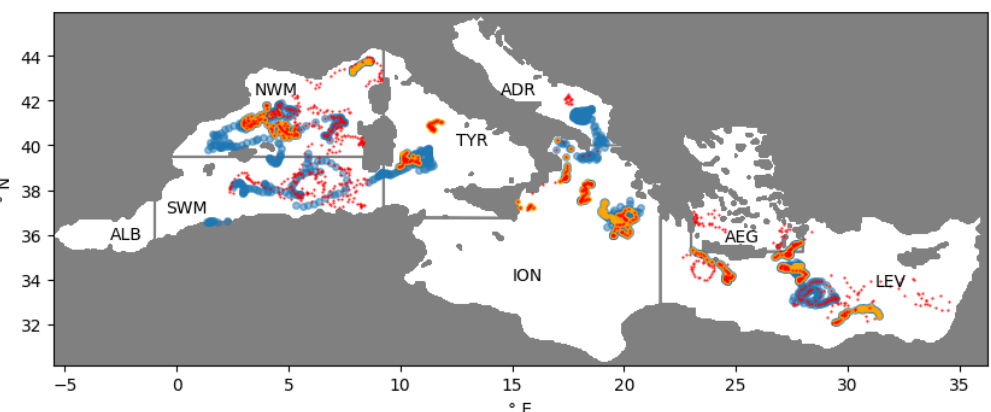
Figure 1. Positions of BGC-Argo floats equipped with sensors to provide chlorophyll (blue), nitrate (orange), and oxygen (red) concentrations and limits of the sub-basins: Alboran (ALB), southwestern Mediterranean (SWM), northwestern Mediterranean (NWM), Tyrrhenian (TYR), Ionian (ION), Adriatic (ADR), Aegean (AEG), and Levantine (LEV)